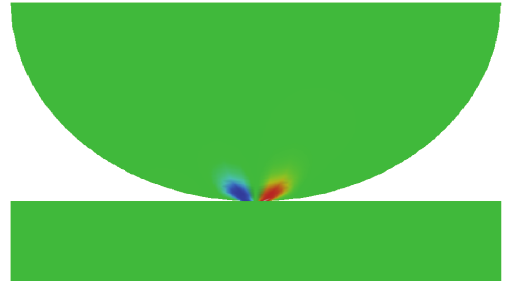
Figure 3: The distribution of couple stress 𝑚 𝑦𝑦